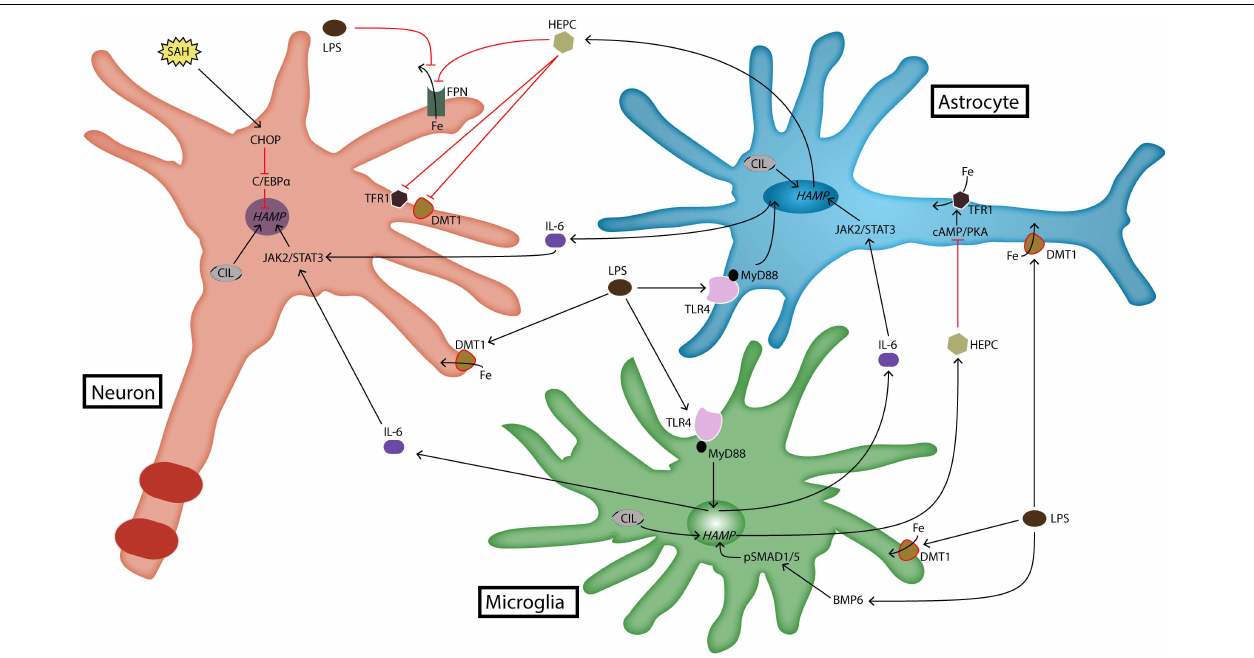
FIGURE 1 | Expression and regulation of hepcidin in brain cells. Brain hepcidin expression is upregulated during inflammation. LPS is a product of inflammation that activates TLR4 receptor. Activated TLR4 induces the production of cytokines such as IL-6, which then goes on to upregulate hepcidin expression via JAK2/STAT3 pathway. Recently, it has been shown that LPS can induce hepcidin expression in microglia through BMP/SMAD pathway as well. LPS is a strong stimulus for iron import, because it induces upregulation of DMT1. Another pathway that can induce hepcidin expression in neurons is realized through CHOP and C/EBP α molecules. This occurs during SAH. In any case, most of hepcidin is produced by glial cells during inflammatory conditions. It acts on target cells by degrading FPN, which reduces iron export out of brain cells. Hepcidin also downregulates iron import proteins, DMT1 and TFR1. In astrocytes this action is realized through cAMP/PKA pathway. BMP6, bone morphogenetic protein 6; cAMP, cyclic adenosine monophosphate; C/EBP α , CCAAT/enhancer-binding protein α ; CHOP, C/EBP homologous protein; CIL, cellular iron load; DMT1, divalent metal transporter 1; Fe, iron; FPN, ferroportin; HAMP , hepcidin antimicrobial peptide gene; HEPC, hepcidin; IL-6, interleukin-6; JAK2, janus kinase 2; LPS, lipopolysaccharide; MyD88, myeloid differentiation primary response 88; PKA, protein kinase A; SAH, subarachnoid hemorrhage; SMAD1/5, s-mothers against decapentaplegic 1/5; STAT3, signal transducer and activator of transcription 3; TFR1, transferrin receptor 1; TLR4, toll-like receptor